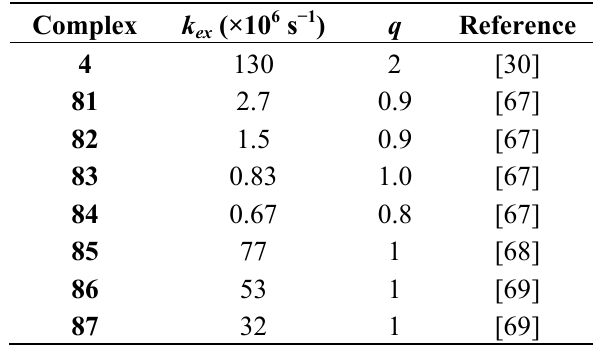
Table 5. Water-exchange rates and water-coordination numbers of Gd III -containing polyaminopolycarboxylate-type ( 81 – 84 ) and HOPO-based ( 4 and 85 – 87 ) PEG conjugates discussed in section